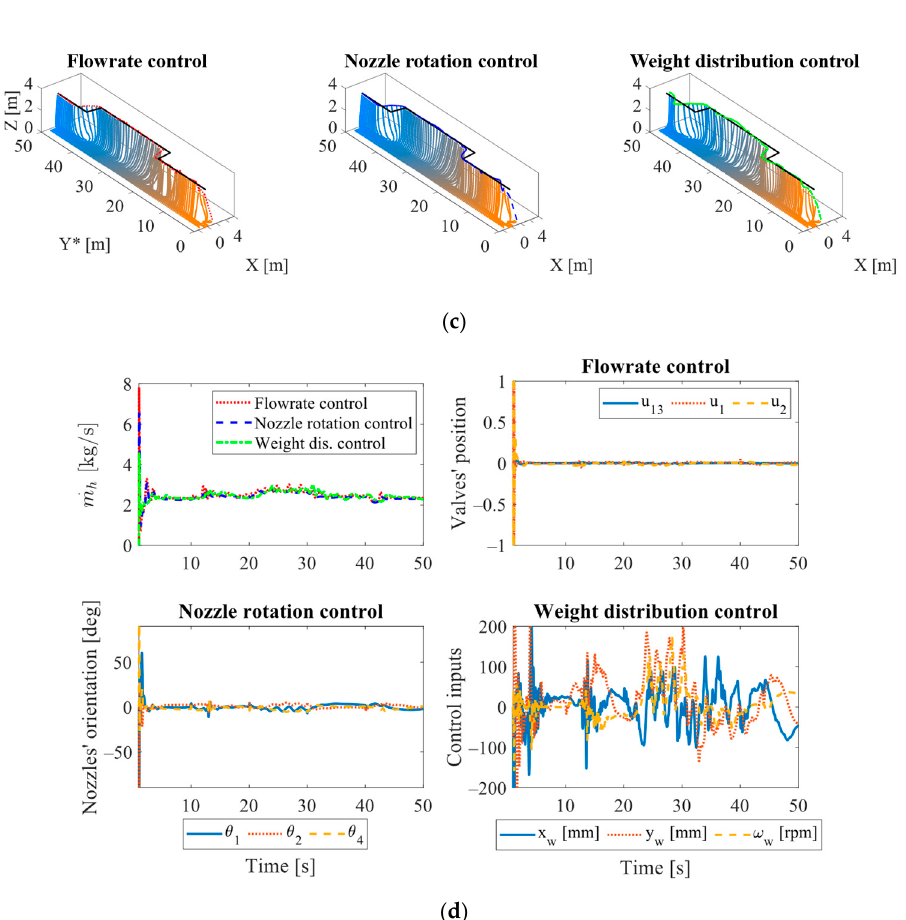
Figure 5. Motion performance of the proposed designs. ( a ) Tracking performance in three-dimen- sional geometry; ( b ) Time responses of translations and rotations; ( c ) three-dimensional partial mo- tion of the water-conveying hose; ( d ) Control inputs.